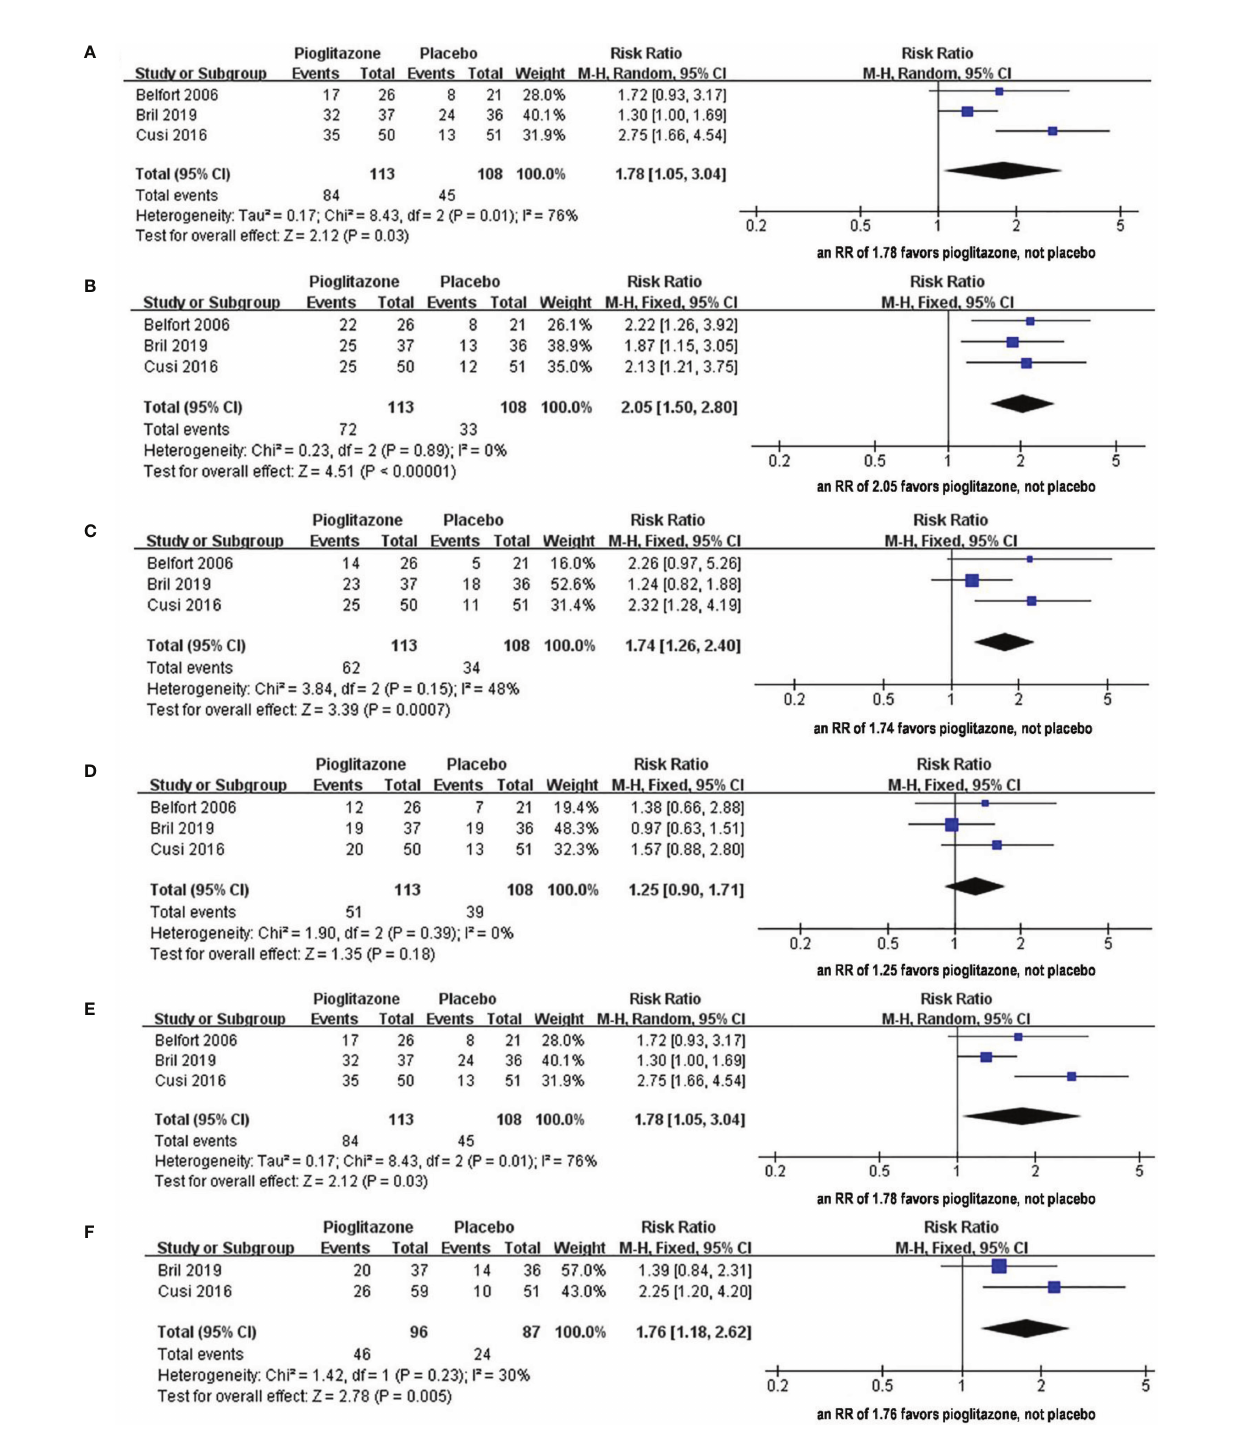
FIGURE 3 | The effect of pioglitazone in hepatic histologic scores(steatosis grade) with improvement of at least 1 grade (A) ; The effect of pioglitazone in hepatic histologic scores(In fl ammation grade) with improvement of at least 1 grade (B) ; The effect of pioglitazone in hepatic histologic scores(ballooning grade) with improvement of at least 1 grade (C) ; The effect of pioglitazone in hepatic histologic scores( fi brosis stage) with improvement of at least 1 grade (D) ; The effect of pioglitazone in resolution of NASH without worsening of fi brosis (E) ; The effect of pioglitazone in reduction of at least 2 points in hepatic histologic scores (from two different parameters)